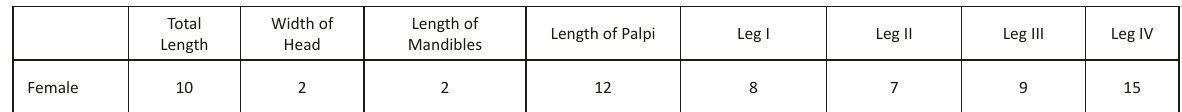
Table 1. Measurements of body parts in